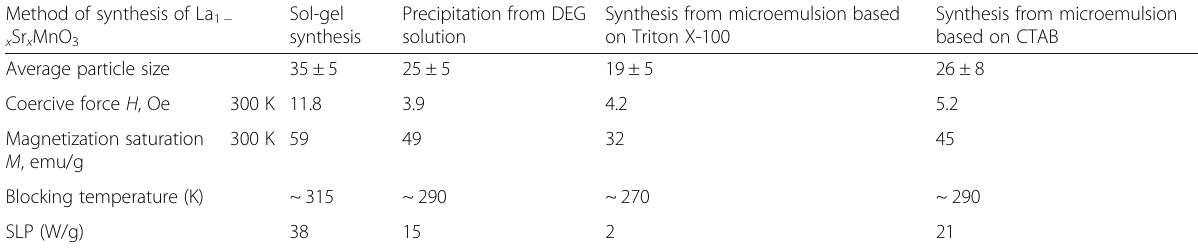
Table 2 Sizes and magnetic parameters for LSMO nanoparticles synthesized via different methods